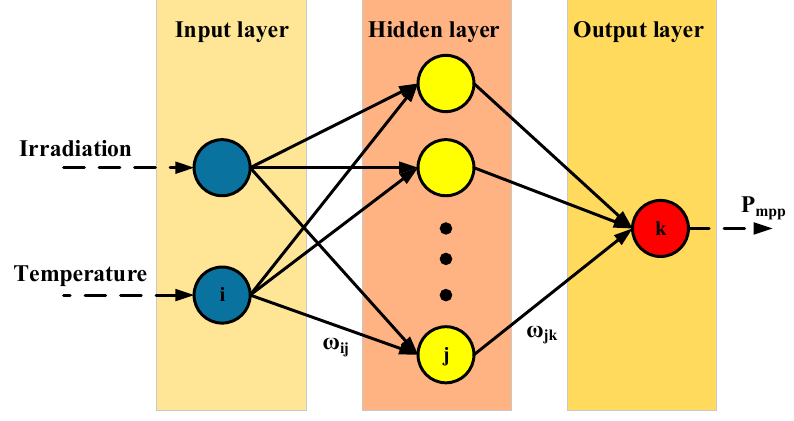
Figure 5. Structure of and ANN in a MPPT.